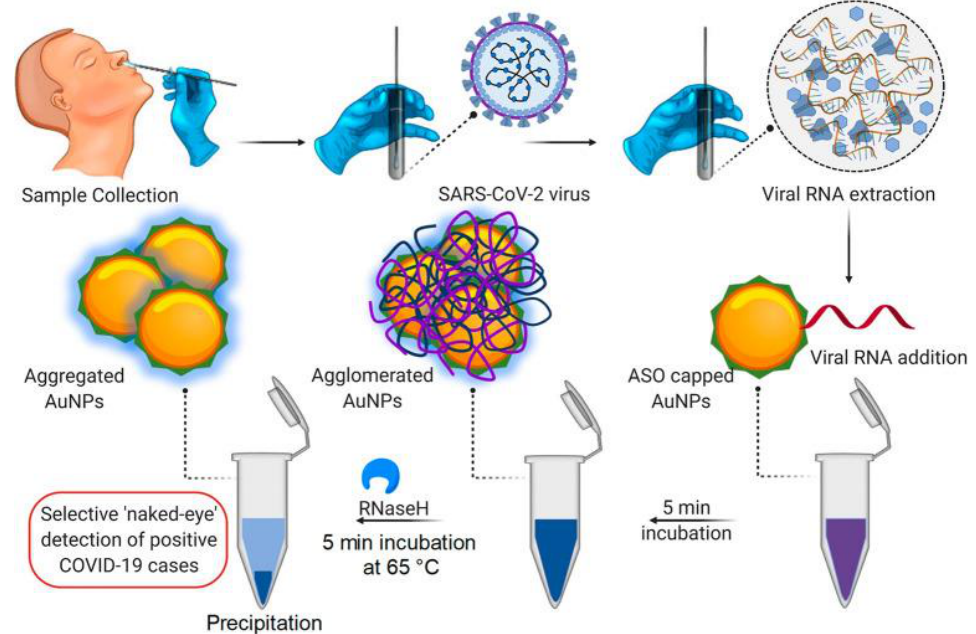
Figure 2. Selective Naked-Eye Detection of SARS-CoV-2 RNA Mediated by the Suitably Designed AuNPs (Adopted from Reference [100] with permission). https://pubs.acs.org/doi/abs/10.1021/acsnano.0c03822, further permissions related to the material excerpted should be directed to the